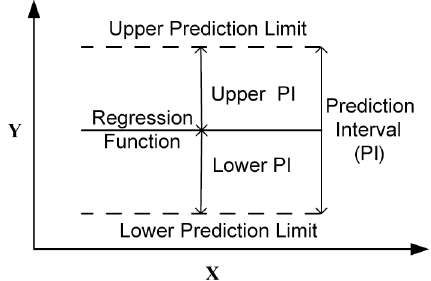
Fig. 1. Prediction limits and prediction interval